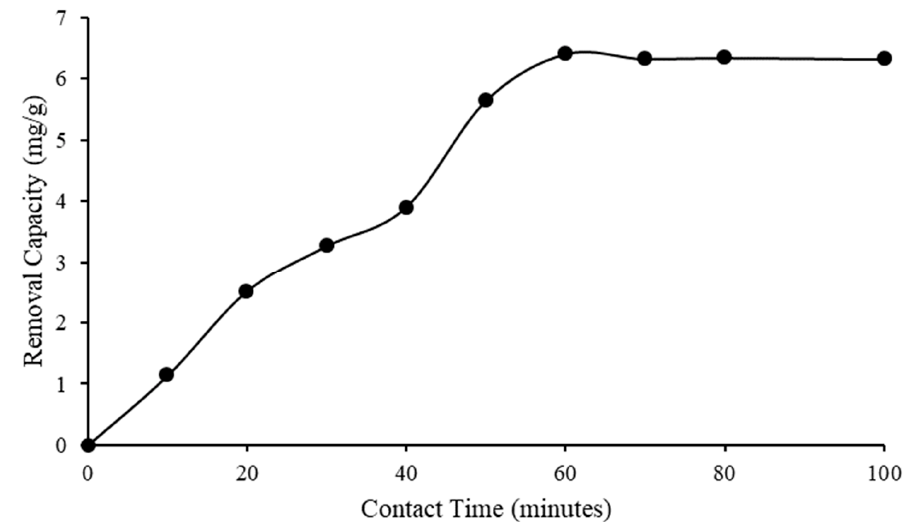
Figure 11. Asphaltene removal capacity after being treated with [C 16 C 1 Pip] 2 [LS].